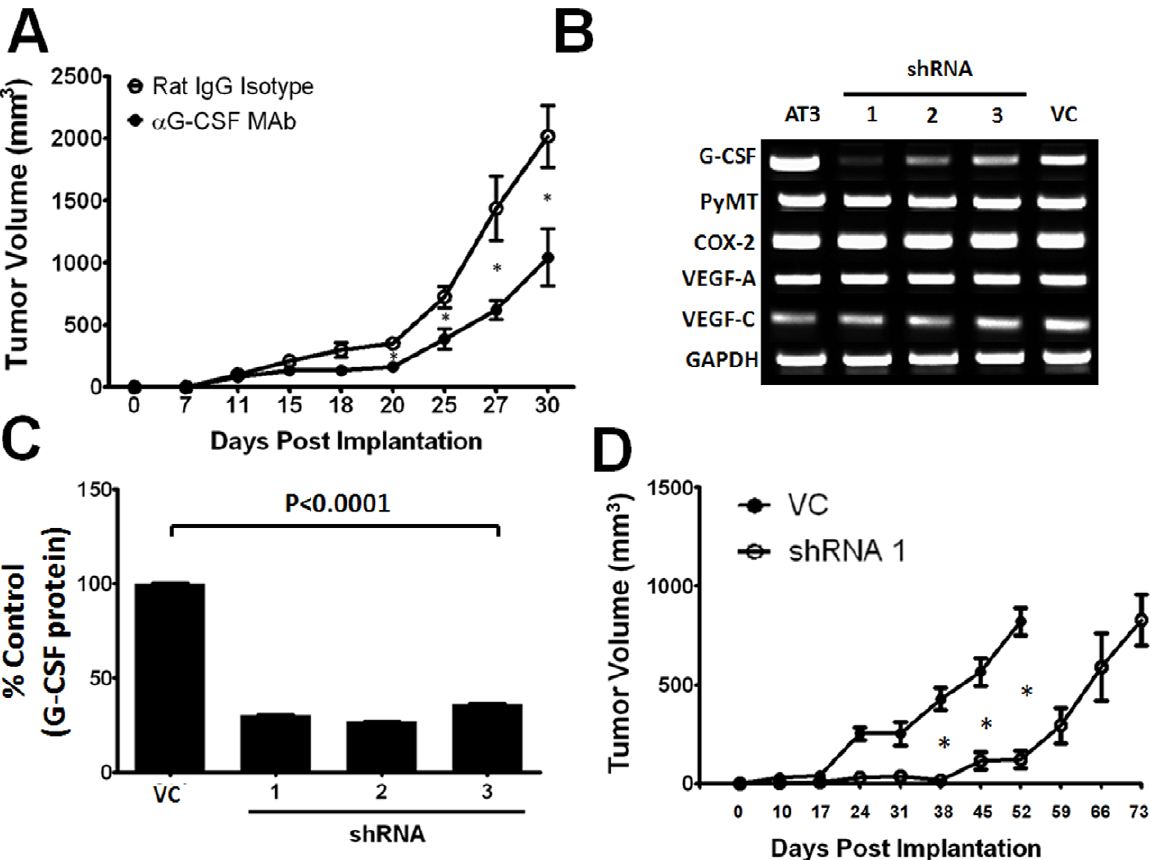
Figure 4. G-CSF blockade slows tumor growth. ( A ) B6 mice were implanted with AT-3 tumor cells, followed 10 days later with treatment with a neutralizing anti-G-CSF mAb or a rat isotype control (10 m g daily for 8 consecutive days). Treatment of mice with anti-G-CSF mAb significantly (* P , 0.05) reduced AT-3 tumor growth at the indicated time points (from days 20-30). Data expressed as the mean 6 SEM of 4 mice/group. ( B ) AT-3 cells were transduced with a scrambled shRNA sequence (non-silencing control) or different G-CSF specific shRNA sequences (constructs 1–3). Individual stable cell lines were propagated in vitro and analyzed for G-CSF expression, along with parental AT-3 cells, by RT-PCR for the indicated genes. ( C ) Cell-free supernatants from G-CSF knockdown vs. non-silencing control cell lines were analyzed for secreted protein by ELISA ( P , 0001) . ( D ) To evaluate the effect of G-CSF knockdown on tumor growth, AT-3 control and AT-3 shRNA-1 cells were implanted into separate groups of B6 mice and monitored for tumor growth (n=5 mice each). G-CSF knockdown led to a significant delay (* P , 0.03) in tumor growth at several time points indicated (from days 38 – 59). Data in panels C & D are reported as mean 6 SEM and are representative of 3 separate experiments.